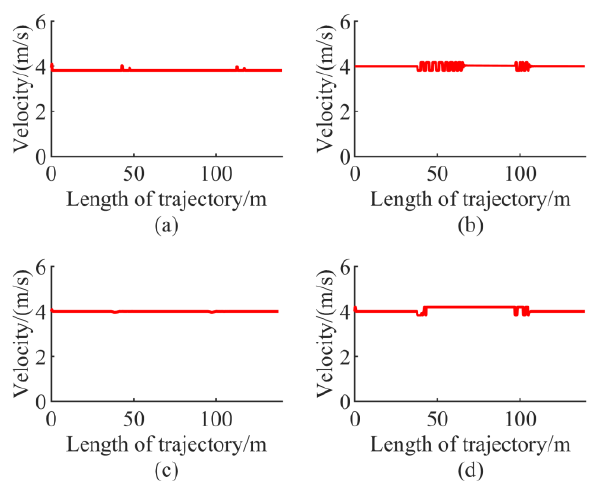
Figure 22. The velocity when parameters changed. ( a ) LMPC. ( b ) LEMPC. ( c ) NMPC. ( d ) NEMPC.